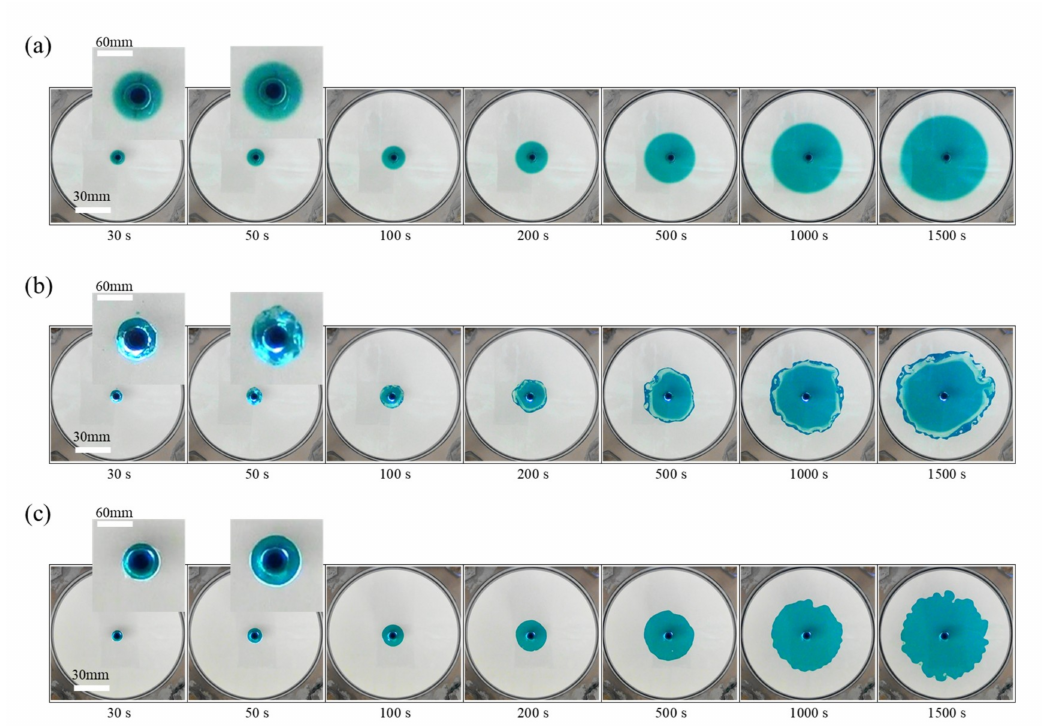
Figure 6. Time evolution of the pattern formation at ( a ) System I, where 20 wt % PEG solution displaces 0 wt % Na 2 SO 4 solution; ( b ) System II, where 20 wt % PEG solution displaces 20 wt % Na 2 SO 4 solution; and ( c ) System III, where 35 wt % PEG solution displaces 20 wt % Na 2 SO 4